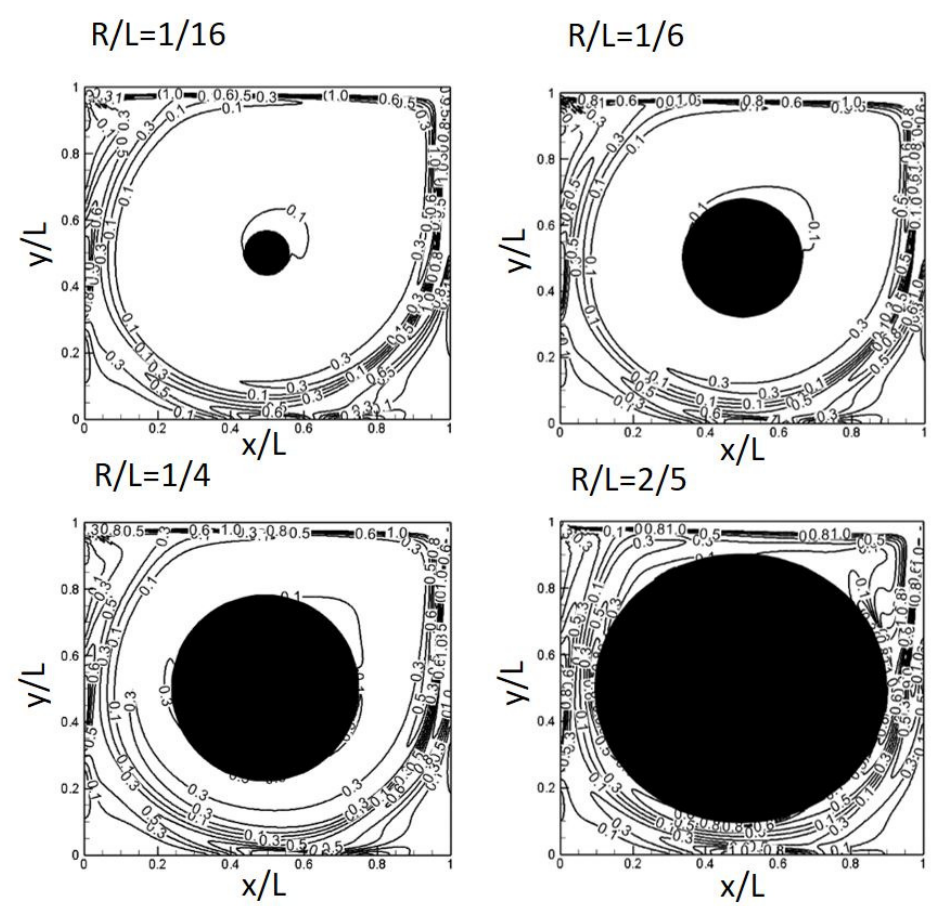
Figure 16. Vorticity contours for obstacle of various